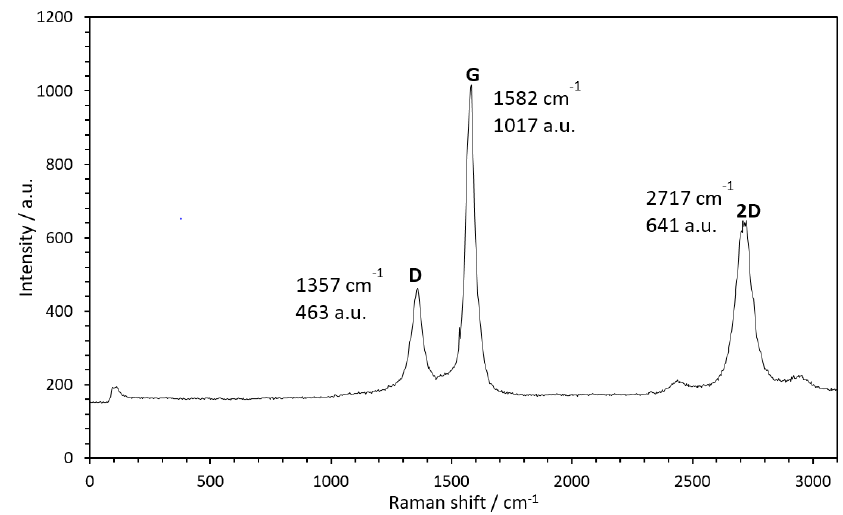
Figure 1. Raman spectra of activated rice husk (ARH), showing the three significant peaks ( D, G, 2D ) for the presence and evaluation of graphene layers.